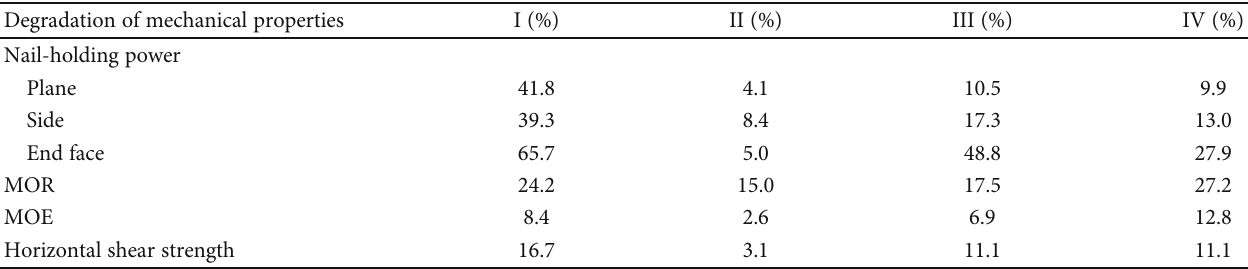
Horizontal shear